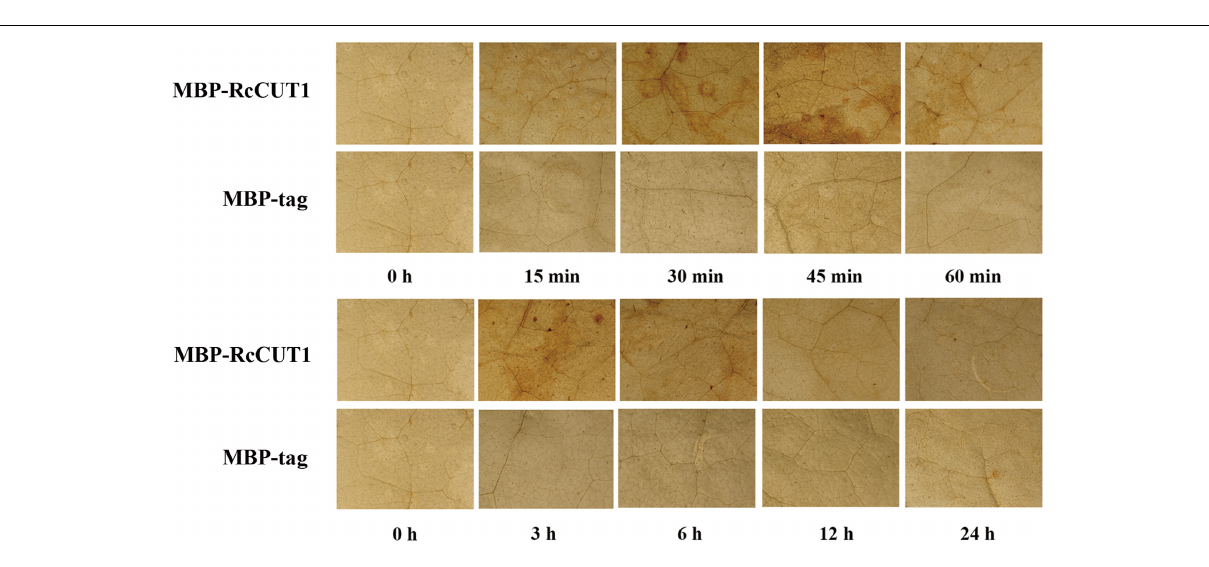
Frontiers in Microbiology |